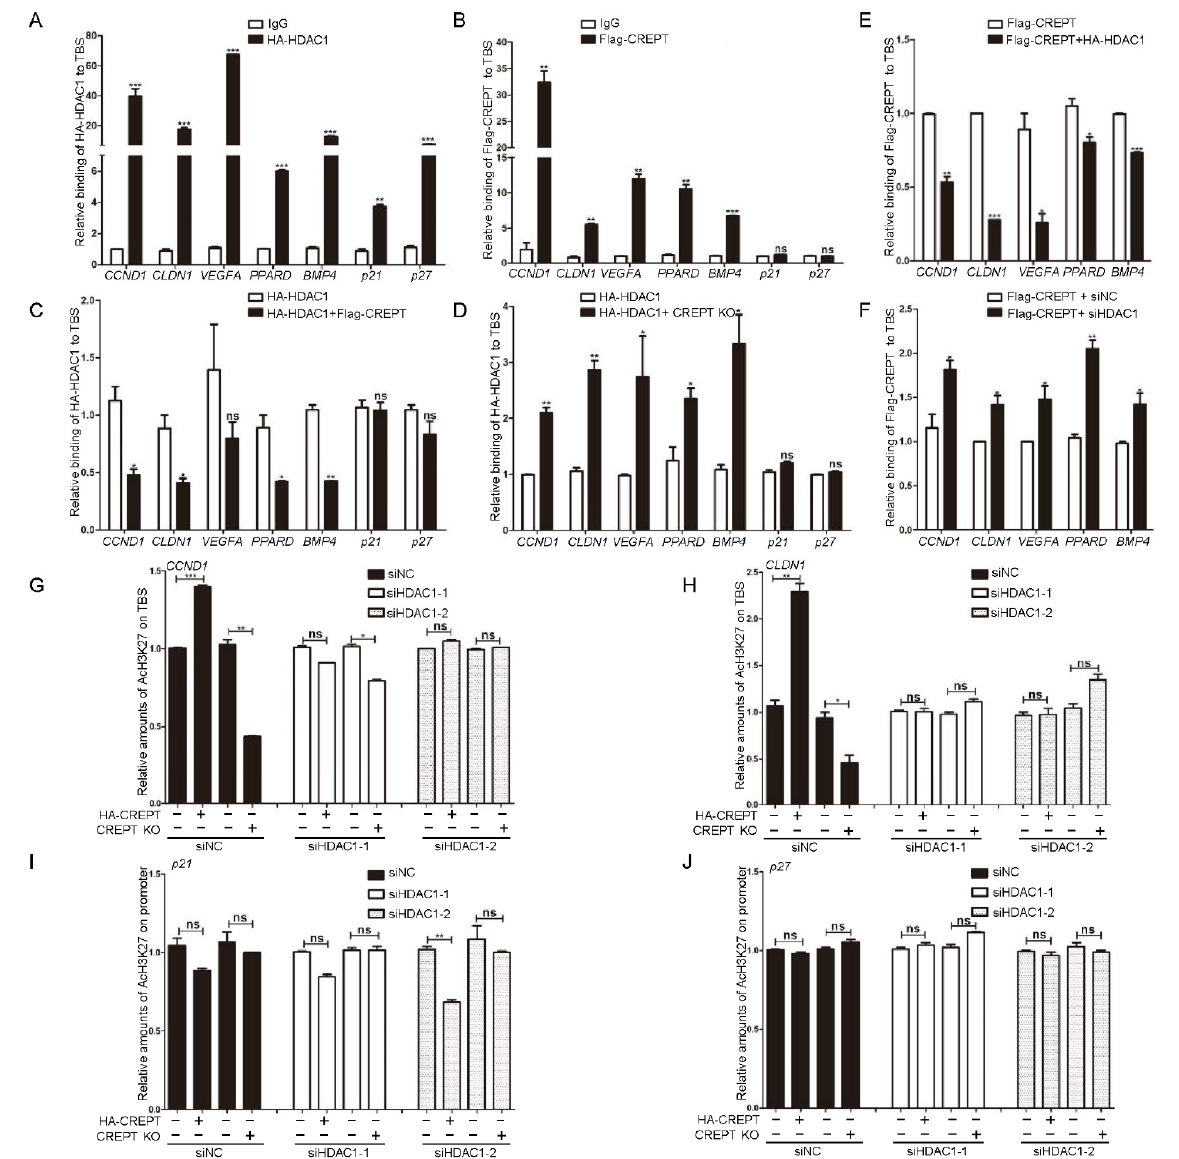
Figure 5. CREPT blocks the occupancy of HDAC1 at the TBS region of target genes. ( A , B ). HDAC1 or CREPT occupies the TCF4 binding sequence (TBS) of Wnt target oncogenes. DLD1 cells overex- pressing HDAC1 ( A ) or CREPT ( B ) were collected for the ChIP-qPCR assay. ( C ). CREPT represses the binding of HDAC1 on the TBS region of Wnt target oncogenes. DLD1 cells under stable expression of HA–HDAC1 and Flag–CREPT were collected for ChIP-qPCR assay. ( D ). Deletion of CREPT facilitates the occupancy of HDAC1 on the TBS region. DLD1 cells under deletion of CREPT were cultured in the presence of over-expressed HA–HDAC1 and harvested for ChIP-qPCR assay using an antibody against HA. ( E ). HDAC1 impairs the binding of CREPT on the TBS region of Wnt target oncogenes. DLD1 cells under stable expression of HA–HDAC1 and Flag–CREPT were collected for ChIP-qPCR assay. ( F ). Deletion of HDAC1 promotes the occupancy of CREPT at the TBS region. DLD1 cells under deletion of HDAC1 were cultured in the presence of over-expressed Flag–CREPT and harvested for ChIP-qPCR assay using an antibody against Flag. The occupancy abundance was revealed by the precipitated DNA fragments on the TBS regions using qPCR. Wnt target oncogenes CCND1, CLDN1, VEGFA, PPARD, and BMP4 were examined. Tumor suppressor genes p21 and p27 were used as